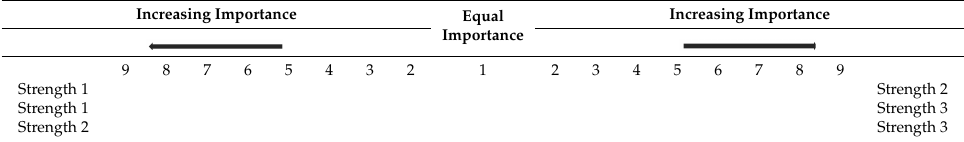
Table 1. An example of a pairwise comparison table (Analytical Hierarchy Process (AHP) method). Increasing Importance Equal